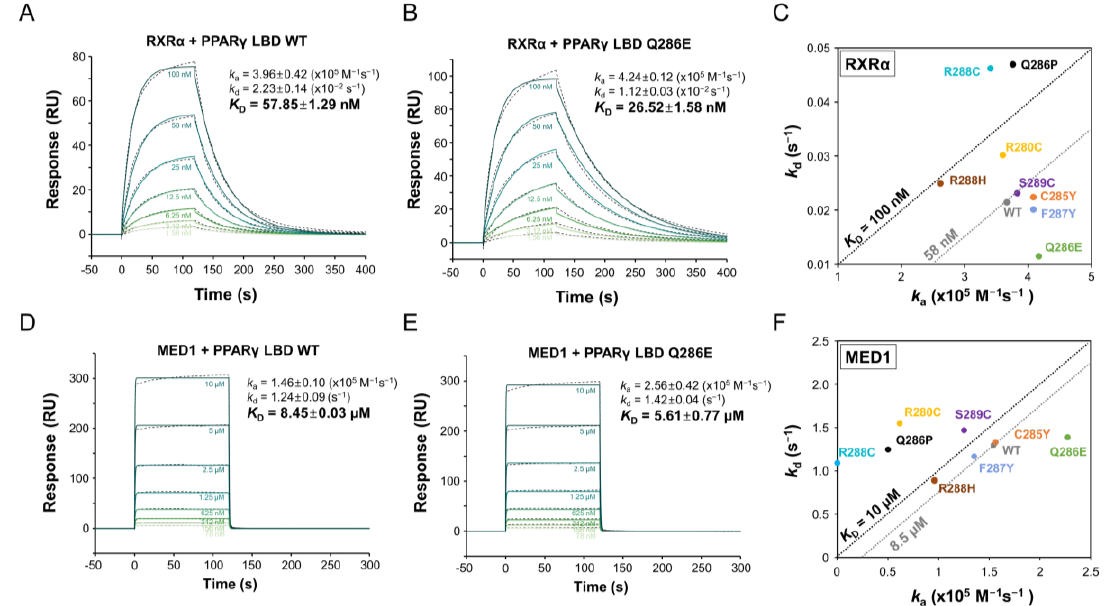
Figure 3. Binding affinities of PPARγ LBD WT and mutants for RXRα and MED1. ( A , B ) SPR sensorgrams for interactions of RXRα LBD with PPARγ LBD WT ( A ) and Q286E ( B ). SPR sensorgrams show the binding of PPAR γ LBD proteins at increasing concentrations to immobilized RXR α LBD. ( D , E ) Sensorgrams for interactions of MED1 peptide with PPAR γ LBD WT ( D ) and Q286E ( E ). SPR sensorgrams show the binding of PPAR γ LBD proteins at increasing concentrations to immobilized MED1 peptides. The equilibrium dissociation constant ( K D ) shown on the right side is calculated by fitting (colored lines) the responses (dotted lines in black color). The data of k a , k d and K D are presented as the mean ± SD of two independent experiments. ( C , F ) Summary of K D values for PPAR γ LBD with RXR α LBD ( C ) and MED1 peptides ( F ). A K D value is obtained from dividing the dissociation rate ( k d ) of Y-axis by the association rate ( k a ) of X-axis. The black- and grey-dashed diagonal lines represent a K D value for a standard and a K D value for the WT,